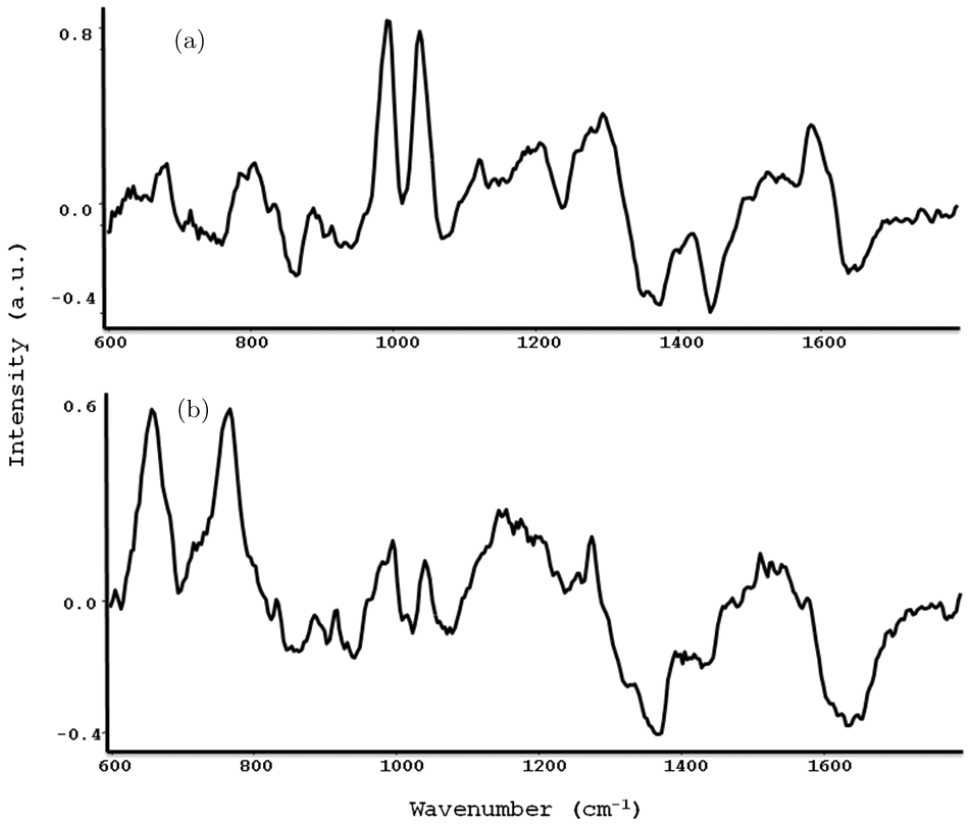
Fig. 5. Di®erence spectra for SERS approach. (a) Highest concentration (1 mg) — blank nanoparticle, (b) Lowest concentration (1 (cid:1) g) — blank